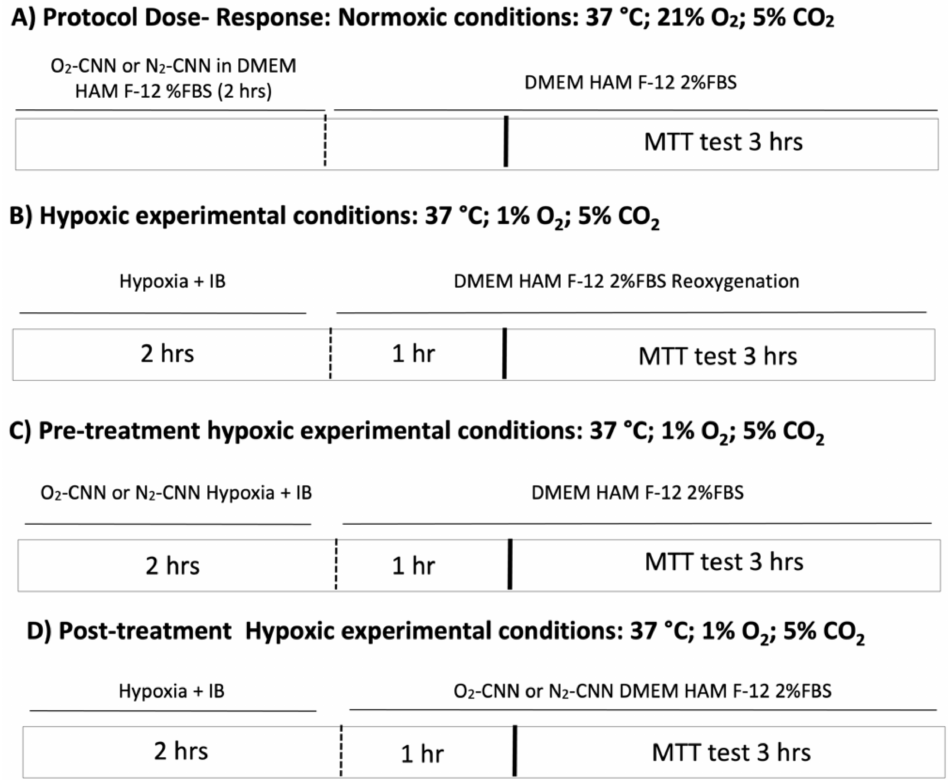
Figure 9. Experimental protocols: ( A – D ) represent different experimental conditions. 3-(4,5- dimethylthiazol-2-yl)-2,5-diphenyltetrazolium bromide (MTT) test. IB: ischemic